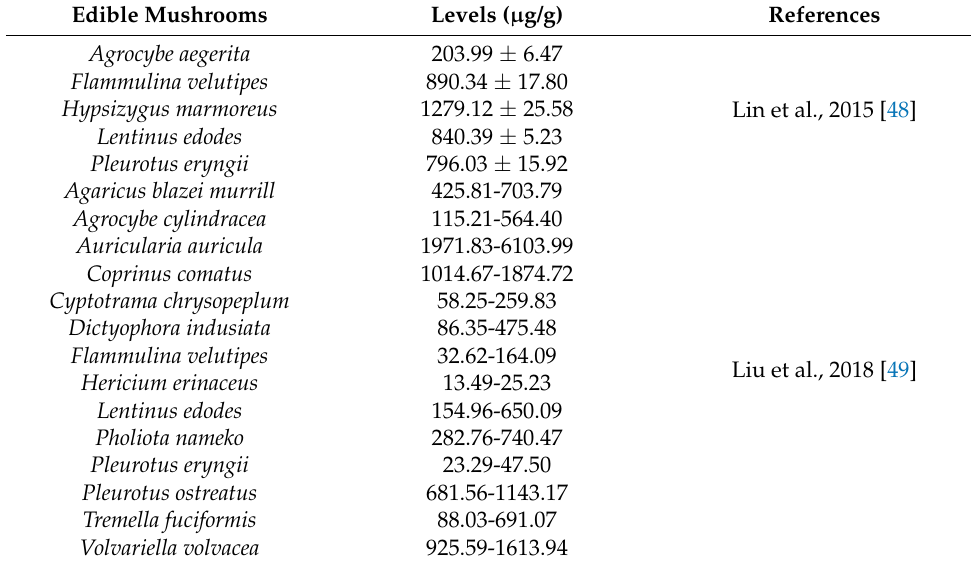
Table 1. Calcium level in some edible